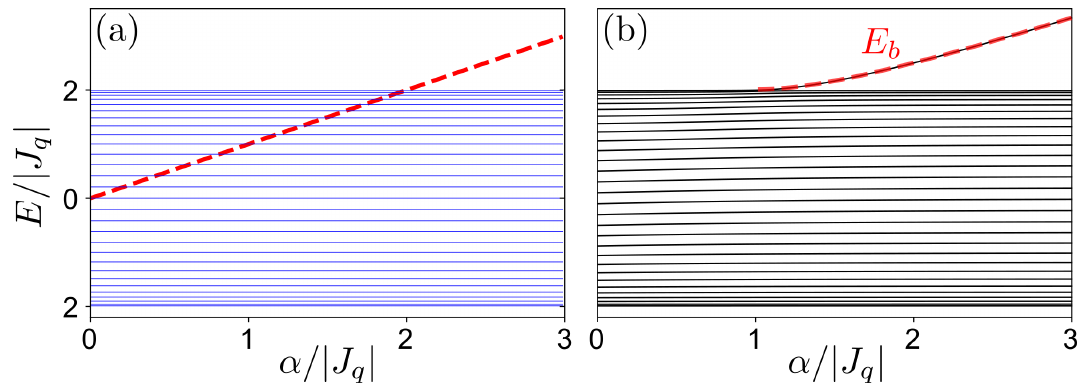
Figure 4: Discrete state coupled to a continuum : (a) Diabatic representation. [ see Eq. (17) ] and the energy of the discrete state Shown are the eigenvalues of ˆ H 0 q | d 〉 (red dashed line). For α < 2 | J | , the discrete state is embedded inside the con- q | , a bound tinuum. (b) Eigenvalues of the coupled Hamiltonian (17). When α > | J q state possessing a large overlap with the state | d 〉 emerges from the continuum. The red dashed line is the energy of the bound state, which is given by Eq. (19). Both panels are obtained with N =